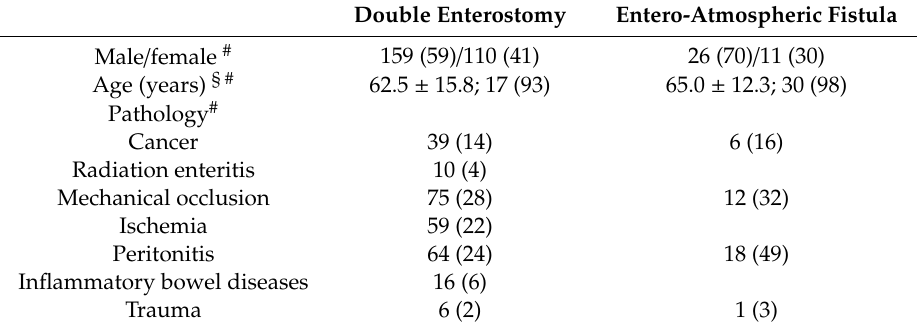
Table 1. Patients’ demographics and pathology ( n =